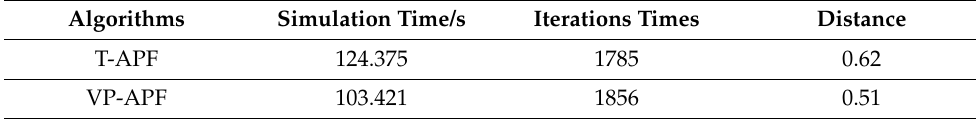
Table 2. Simulation comparison result of different algorithms.